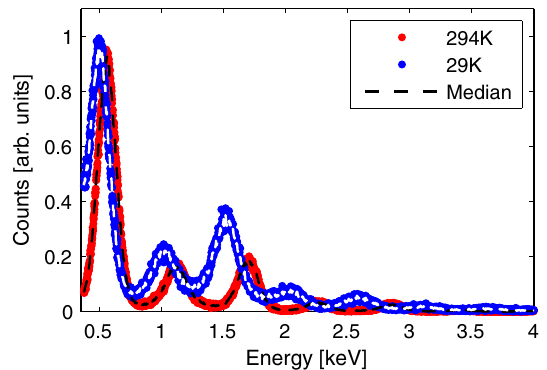
FIG. 3. Comparison of the undulator ’ s spectral output at RTand at 29 K measured by a Germanium detector. The spectra are normalized to the peak count of the fundamental ’ s flux density at RT. A shift of the peak energies and a gain in flux density due to the increasing K parameter is observed. The measurement is in good agreement with Eq. (5).